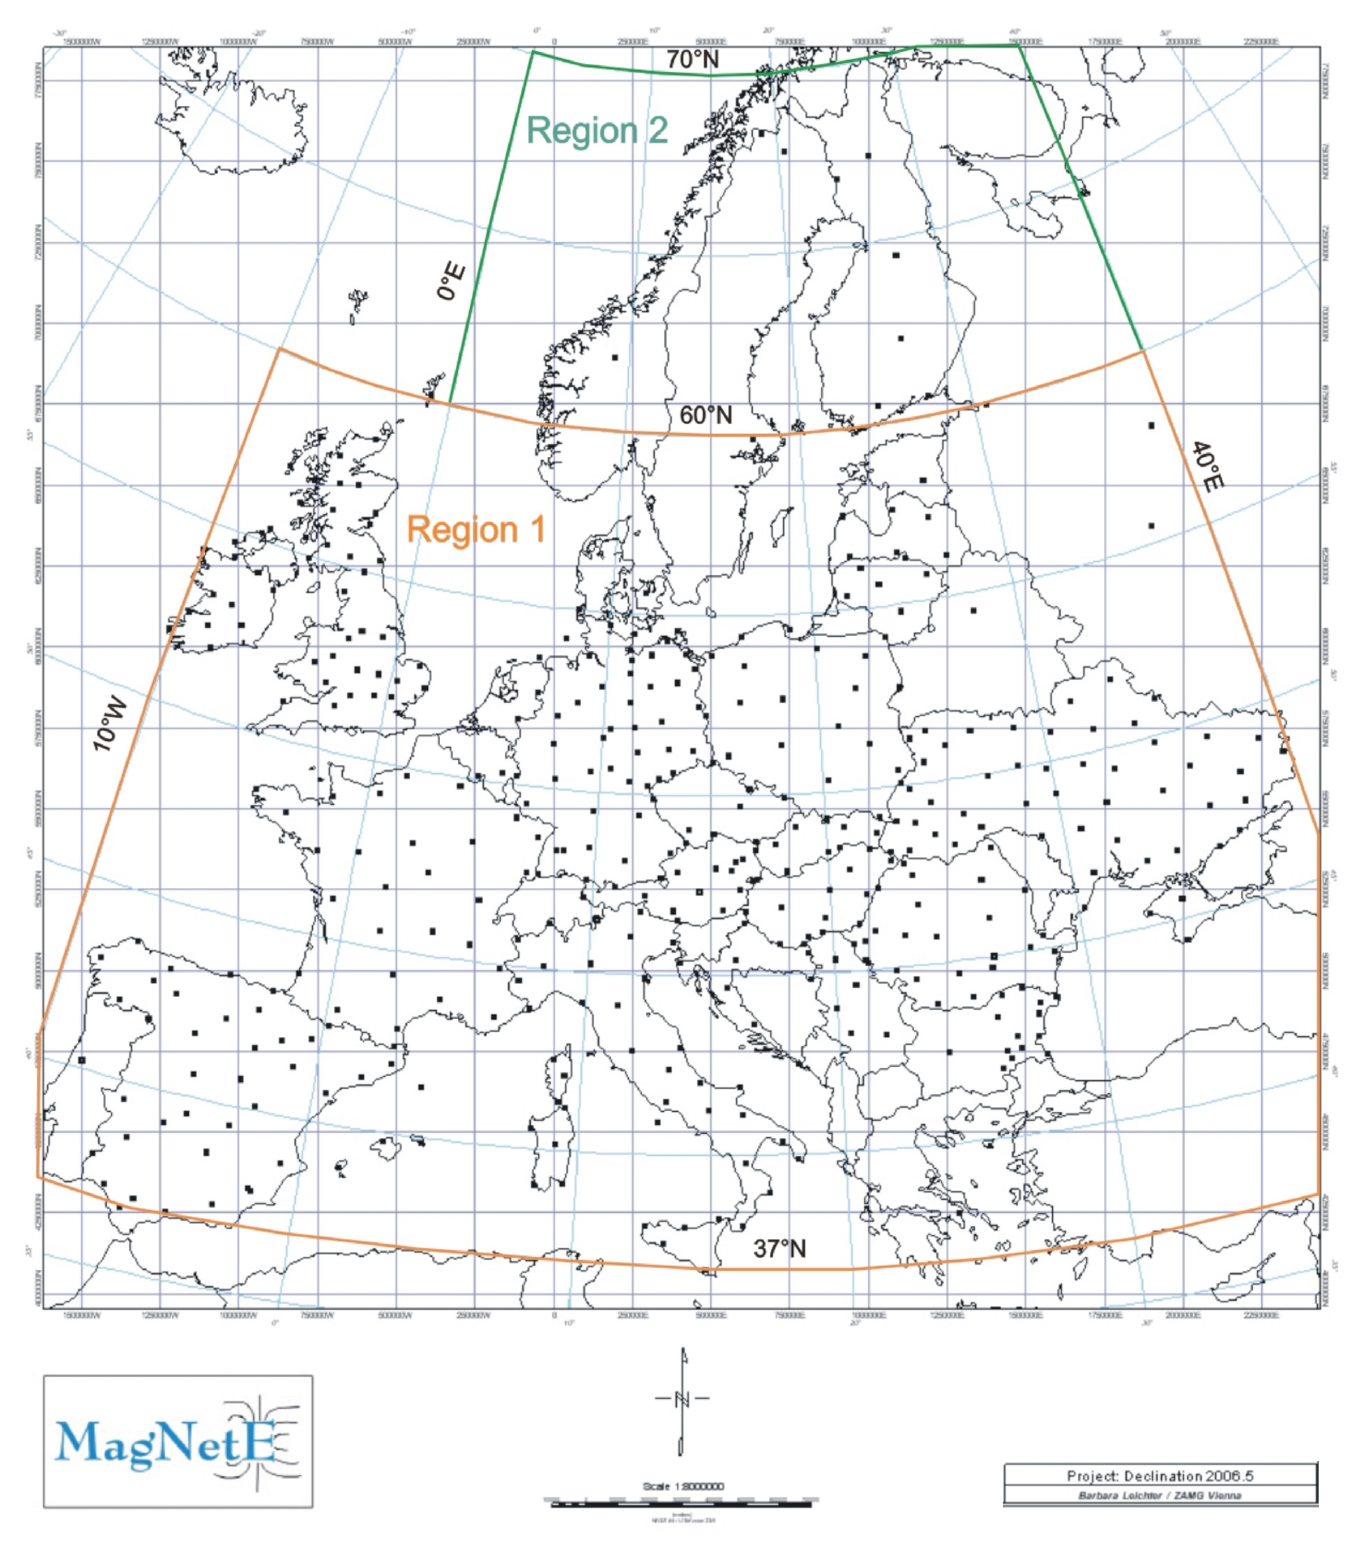
Figure 4. Magnetic Repeat Stations 2006.5. Geographical distribution of all points of measurement in 21 states, the data of which contributed to produce the European geomagnetic chart for 2006. Region 1 and Region 2 mark areas with different density of measurement